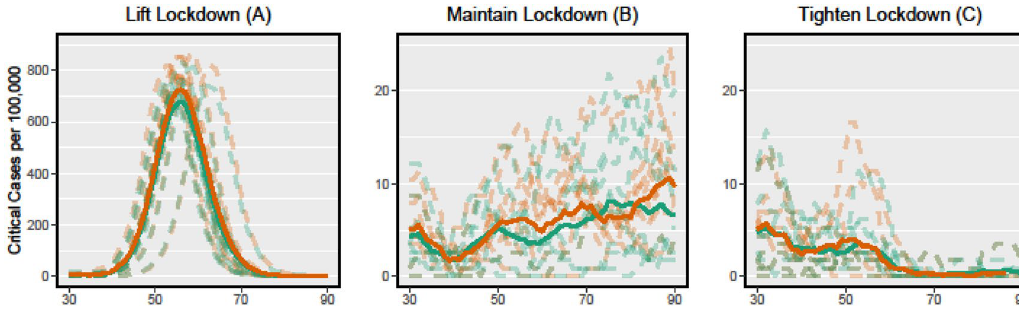
Figure 2. Policy impacts on the critical cases (time). Simulated course of COVID-19 in three policy scenarios corresponding to Fig. 1. The dashed green lines indicate the number of critical patients in scenarios without consideration of TB, the dashed red lines accordingly represent the critical cases under consideration of a TB risk group. For each scenario 10 simulations are computed, the solid lines represent their averages.